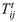
Joint climate change impact and human migration modeling process.The joint model takes a list of spatial zones θ and climate change features xt as input, and outputs a migration matrix
Tt, where an entry Tijt represents the number of migrants that travel from zone i to j at time t.